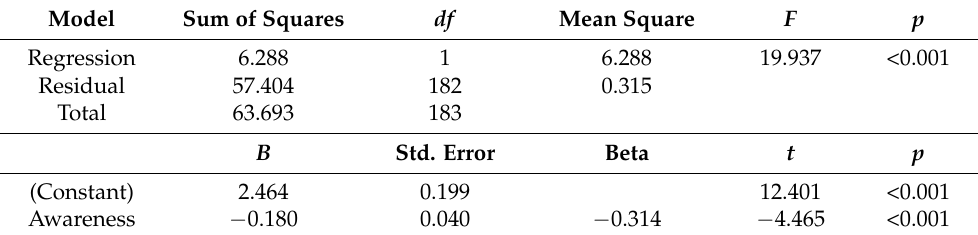
Table 2. Model fit and regression coefficients on COVID-19 awareness predicting teachers’ anxi- ety